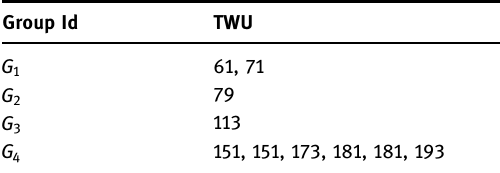
Table 5: TWU - grouping using JNB for items in database 1